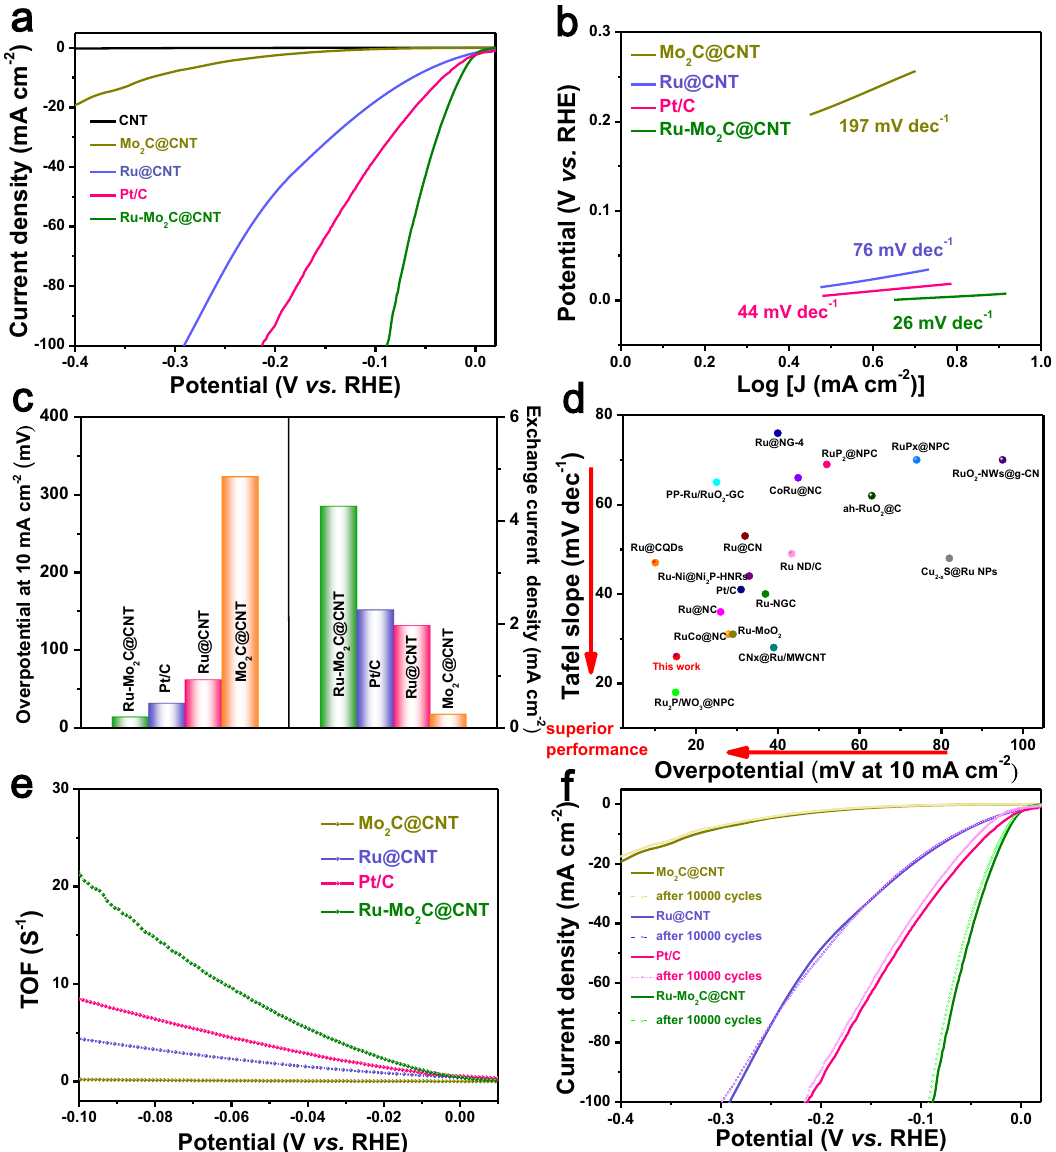
Fig. 3 Electrocatalytic HER performance test of catalysts in N 2 -saturated 1.0 M KOH solution. a HER polarization curves of CNT, Mo 2 C@CNT, Ru@CNT, Pt/C, and Ru-Mo 2 C@CNT catalysts. b Tafel plots obtained from the polarization curves in a . c Comparison of overpotential changes at 10 mA cm − 2 and exchange current density. d In 1.0 M KOH solution, compared with the recently reported HER catalyst Tafel slope and overpotential at 10 mA cm − 2 . e The potential-dependent TOF curves of Mo 2 C@CNT, Ru@CNT, Pt/C, and Ru-Mo 2 C@CNT. f Polarization curves for Mo 2 C@CNT, Ru@CNT, Pt/C, and Ru- Mo 2 C@CNT catalysts before and after 10,000